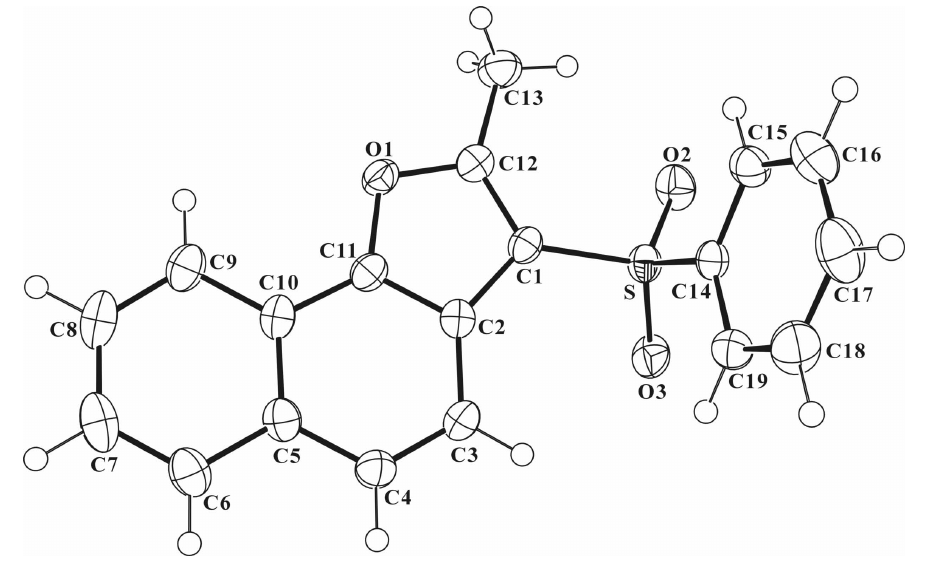
Figure 1 The molecular structure of the title compound, showing displacement ellipsoides drawn at the 50% probability level.